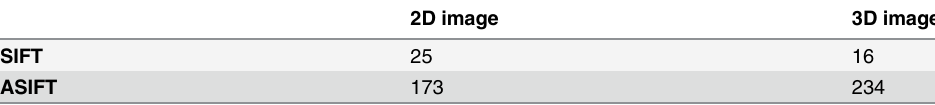
Table 1. Comparison of numbers of keypoints from SIFT and